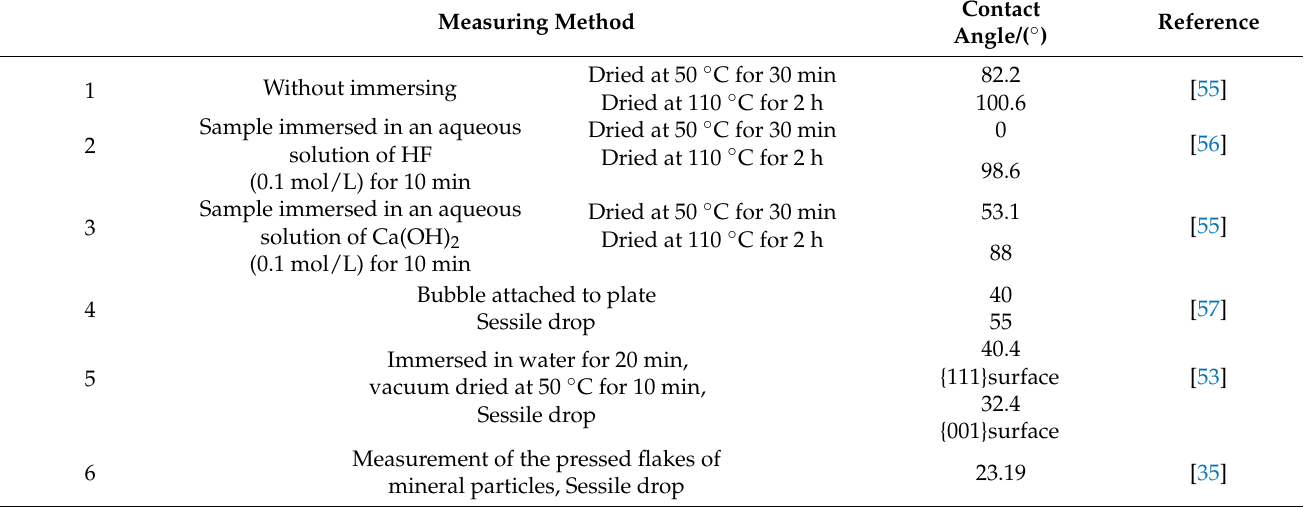
Table 1. A summary of the fluorite contact angle reported in the